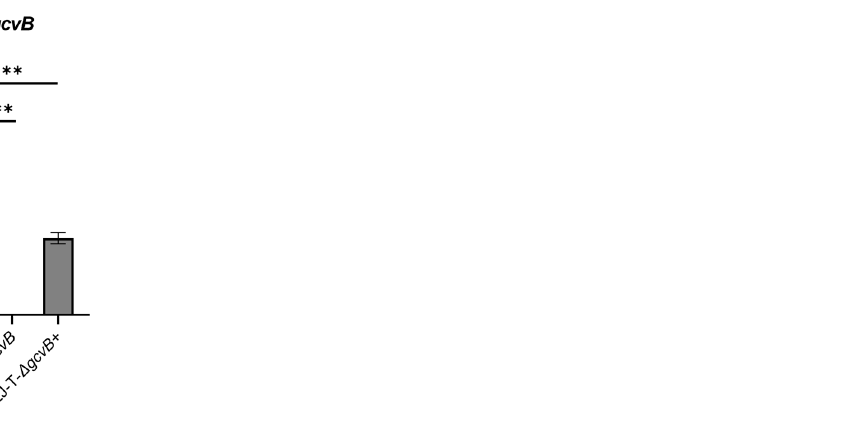
Figure 2. The relative expression of gcvB in wildtype, gcvB mutant and complementary strains (Student ’s t -test, p value: **, <0.01, ****, <0.0001). The levels of gcvB were normalized to the internal control 16S rRNA level. Error bars indicate standard deviations.